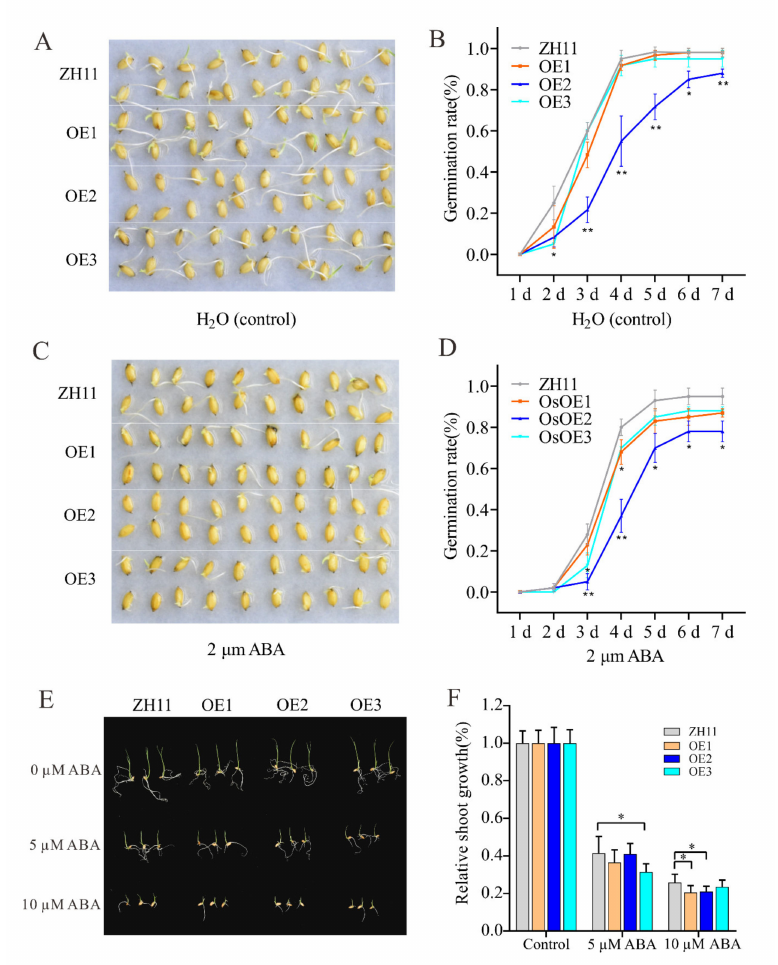
Figure 8. ZmHsf05 influences seed germination and shoot growth. Each experiment utilizes three transgenic rice lines (OE1, OE2, and OE3) and wild-type ZH11. ( A ) Germination performance of transgenic rice and ZH11 in H 2 O at seven days after initiation. ( B ) Calculation and statistical analysis of the germination rate of transgenic and ZH11 rice seed in water. A seed was suggested to germinate when the length of radicle was longer than half of the seed. ( C ) Germination performance of transgenic rice and ZH11 in water containing 2 µ M of ABA. ( D ) Germination rate of transgenic rice and ZH11 rice seed in water containing 2 µ M of ABA. ( E ) The shoot growth of transgenic rice showed hypersensitivity to exogenous ABA. ( F ) Relative shoot length of transgenic rice and ZH11 with the addition of exogenous ABA. Three biological replicates were used for performed for each experiment. Representative graphs are shown ( n = 20 seeds in each experiment). *, p < 0.05 and **, p < 0.01 (Student’s t